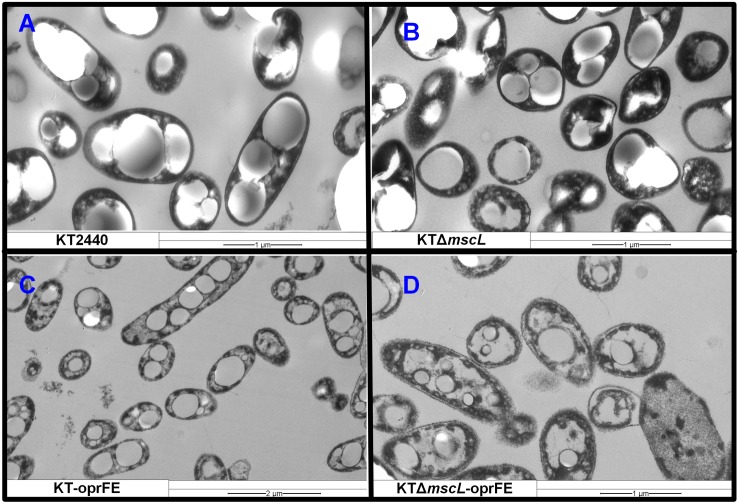
Transmission electron microscopy pictures of Pseudomonas putida cells producing PHA on decanoate after osmotic treatments. (A) KT2440, (B) KTΔmscL, (C) KT-oprFE, and (D) KTΔmscL-oprFE strains.